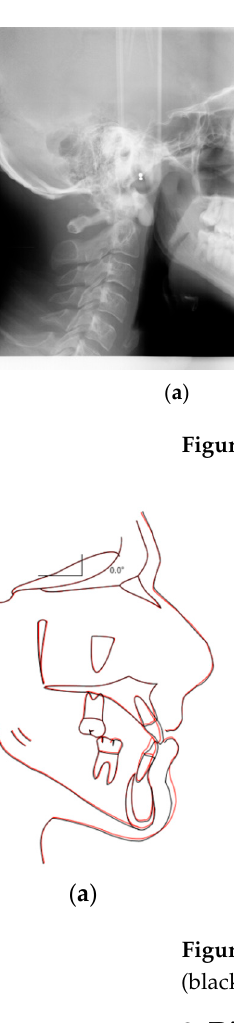
Figure 5. Post-treatment extra- and intra-oral records.